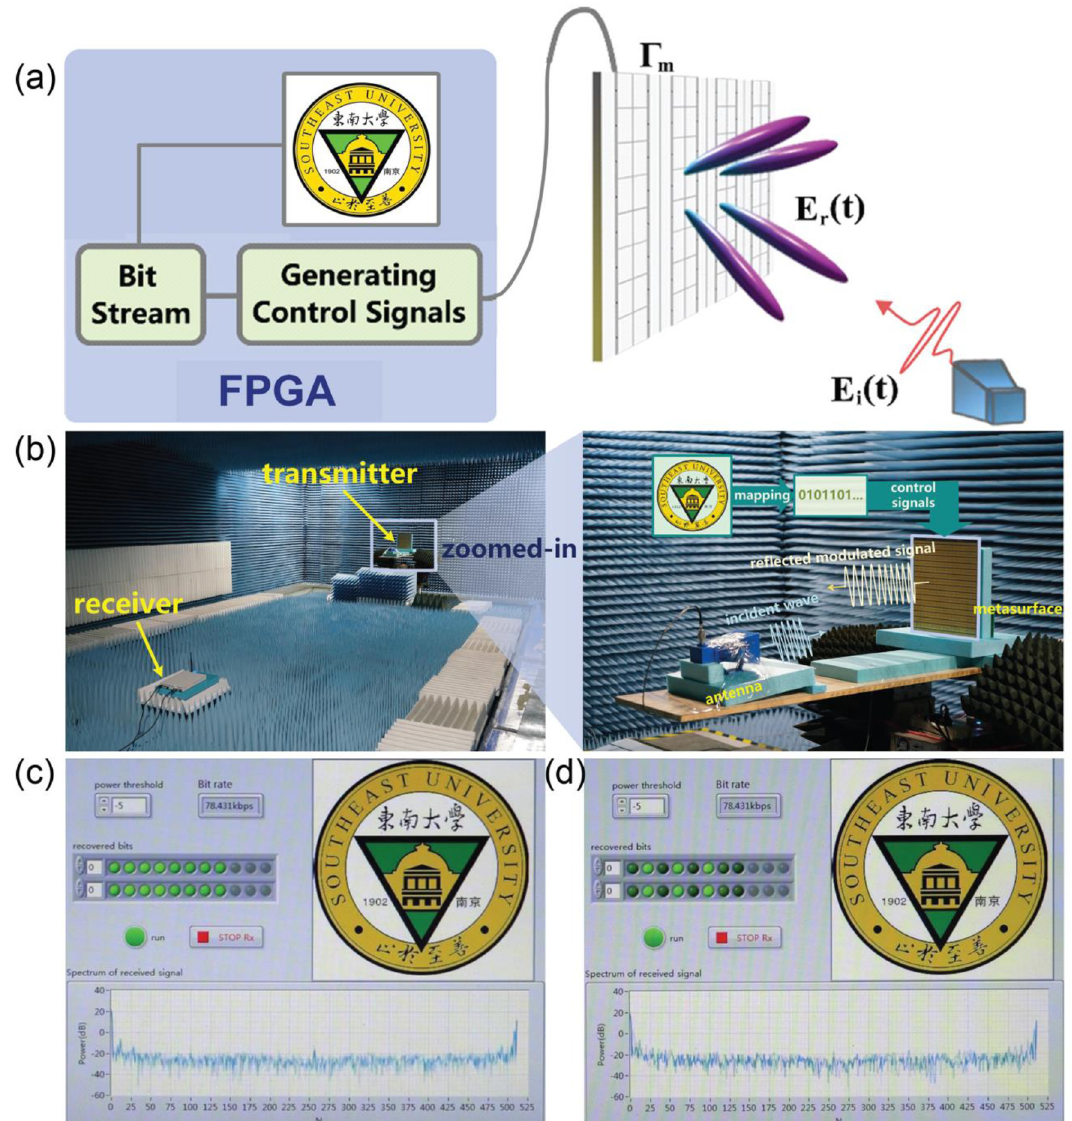
Fig. 7. BFSK transmission system based on space-time coding digital metasurfaces (adapted from [32]). (a) Conceptual illustration. (b) Photographs of the prototype and measurement setup. (c, d) Measurement results with receiving angle of 0 ° and 30 ° ,